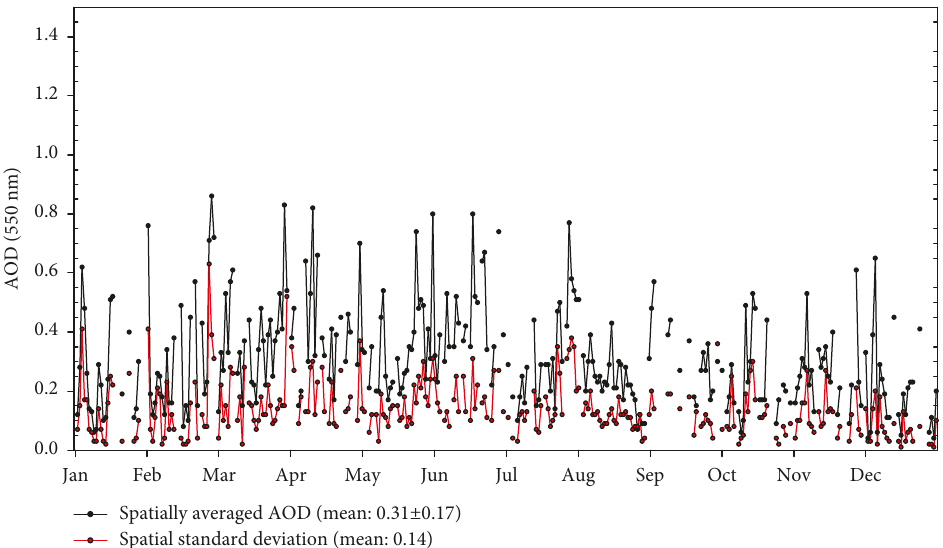
550 in South Korea (year